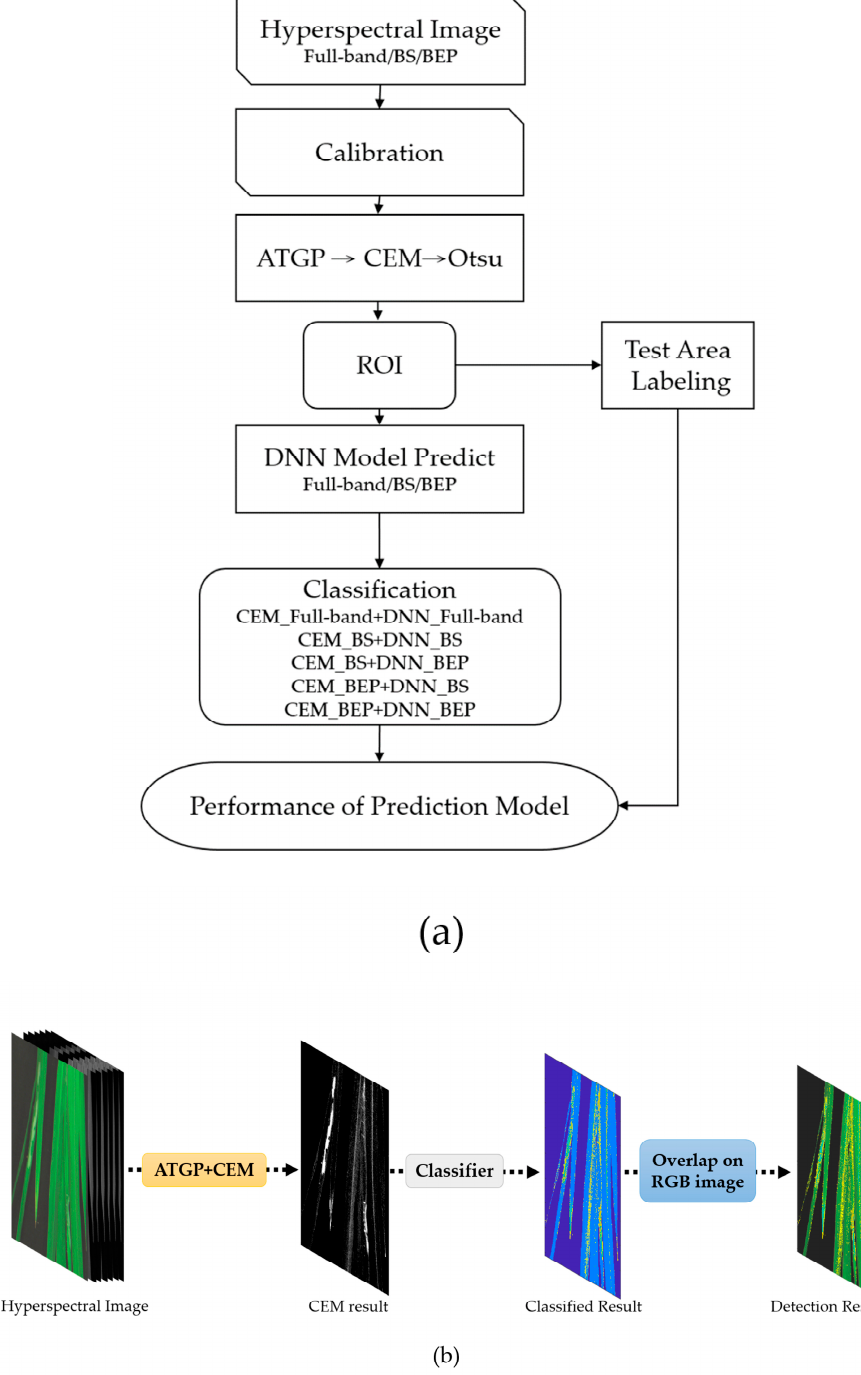
Figure 6. ( a ) Flow chart of the DNN model is used to predict unknown samples. ( b ) Flow chart of DNN model